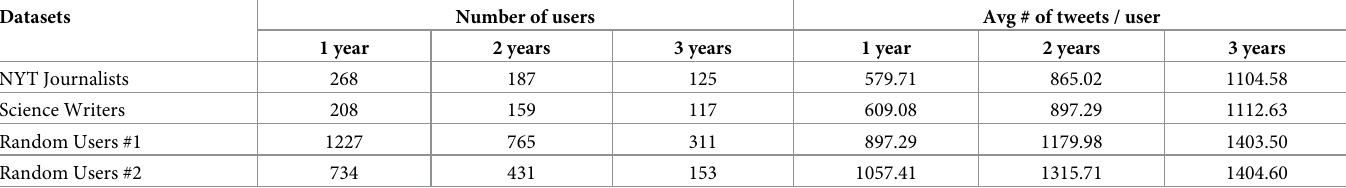
Table 1. Datasets summary. Number of users and tweeting frequency at different observation windows.